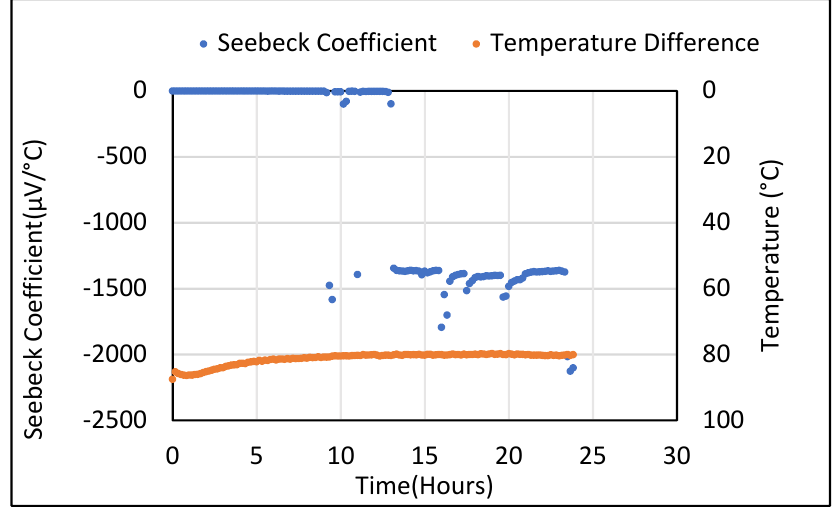
Figure 4. Seebeck coefficient of control sample at fixed temperature difference.